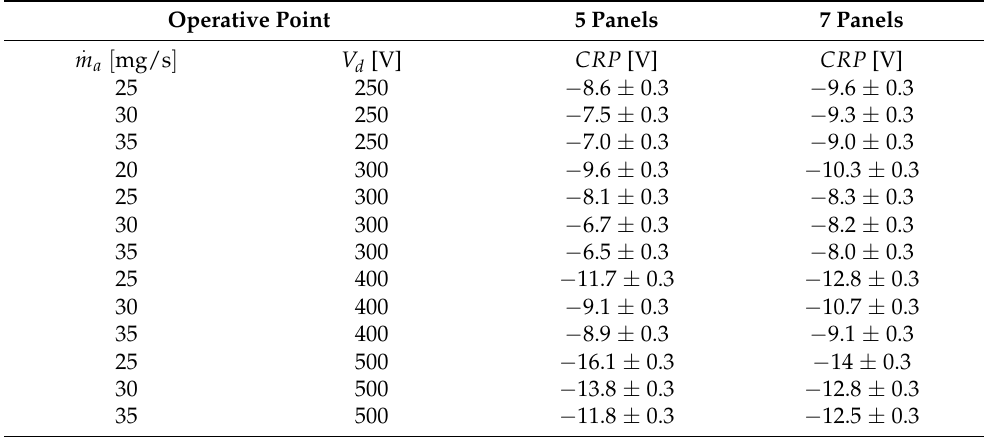
Table A3. CRP (cathode reference potential) for the various operative conditions of the HT20k